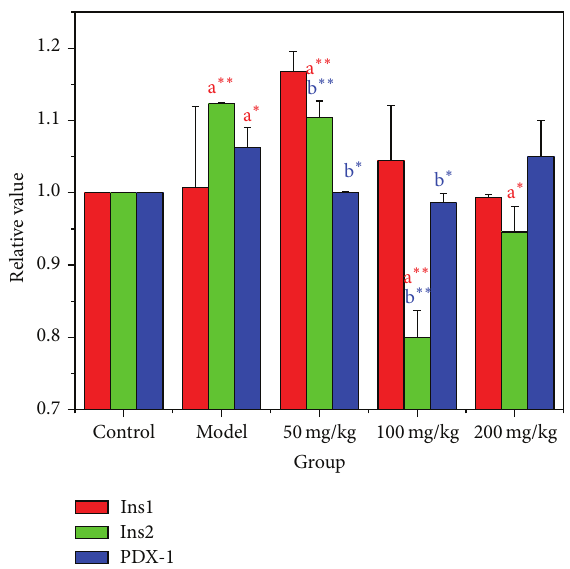
Figure 7: The effect of HuSang 32 BBE on STZ-induced diabetic mice Ins1, Ins2, and PDX-1 mRNA expression. a ∗ , compared with normal control group, 𝑃 < 0.05 , significant difference; a ∗∗ , compared with normal control group, 𝑃 < 0.01 , very significant; b ∗ , compared with model group, 𝑃 < 0.05 , significant difference; b ∗∗ , compared with model group, 𝑃 < 0.01 , very